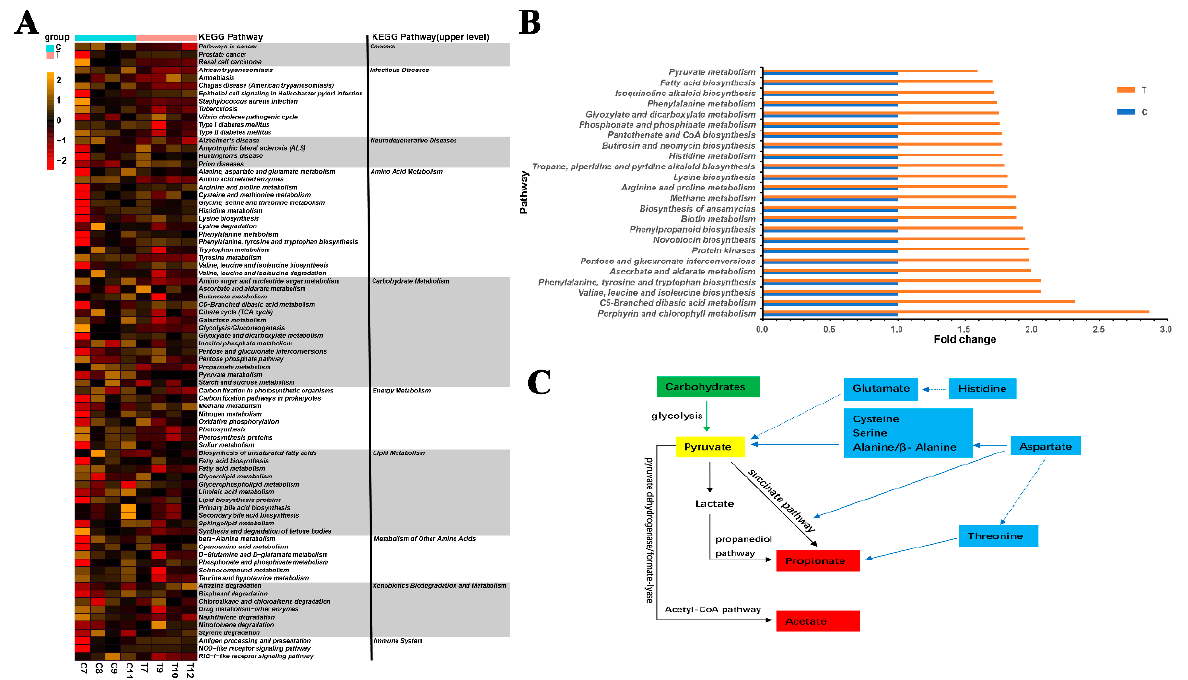
Figure 4. Gene functional pathways and metabolic pathways related to CF11 intervention. ( A ) Bac- terial gene functions were predicted from 16S rRNA gene-based microbial compositions using the PICRUSt algorithm to make inferences from KEGG-annotated databases. KEGG pathway counts